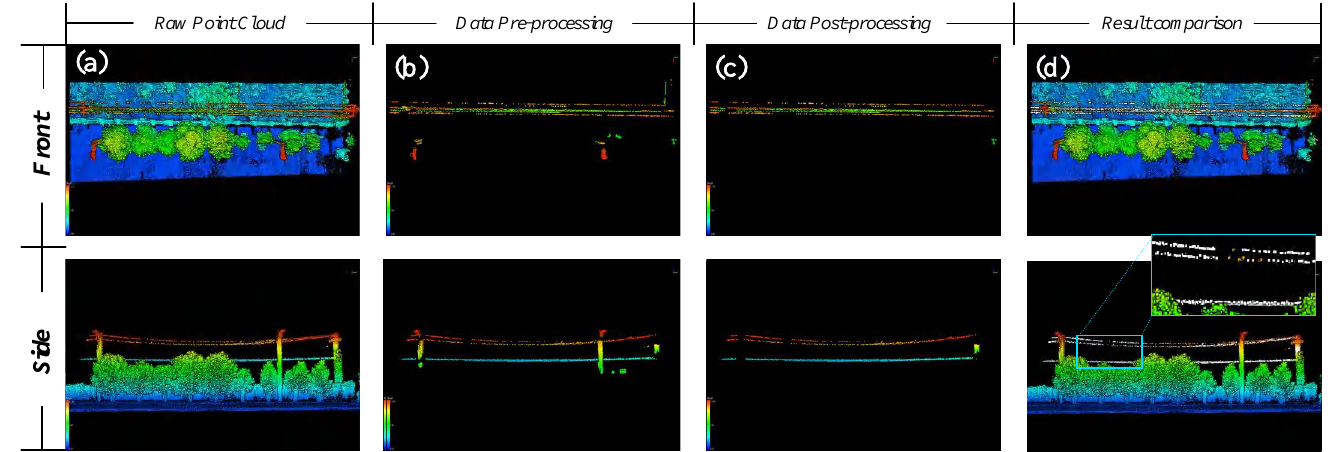
Figure 6. Views of the third group of sample point clouds from the front and side (order from left to right): ( a ) before segmentation and extraction; ( b ) after preprocessing; ( c ) after segmentation and extraction; ( d ) the comparison display (marked in white and